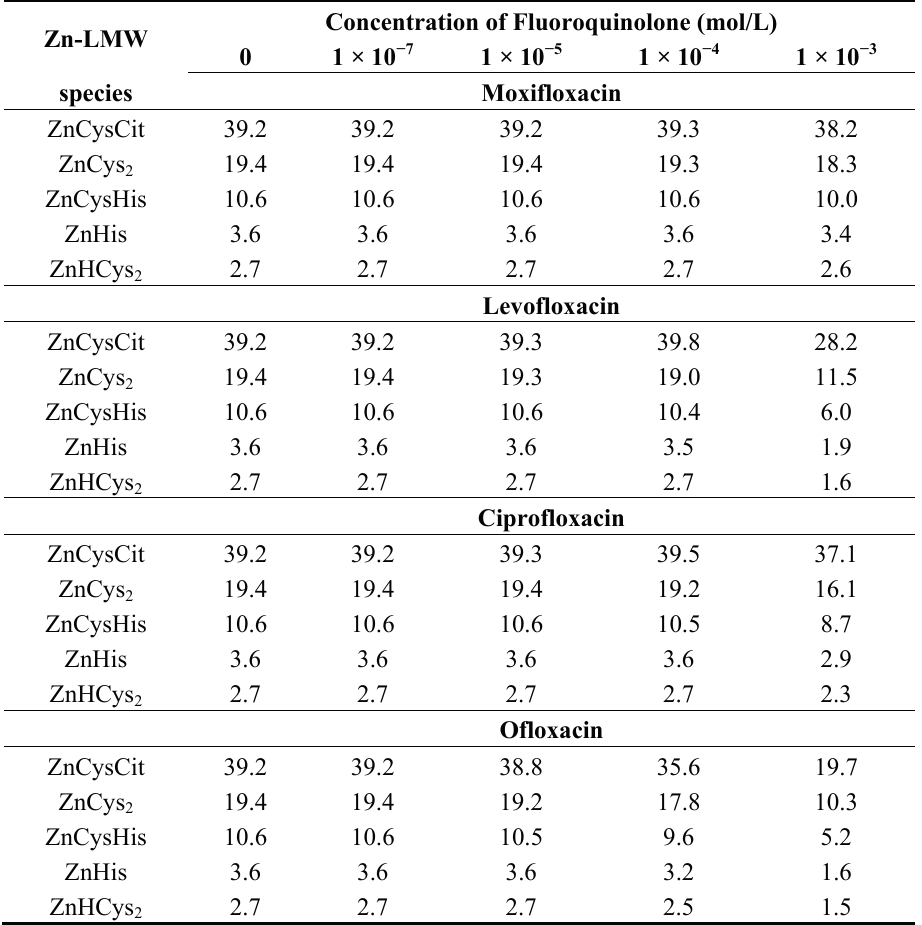
Table 11. Calculated bio-distribution of dominant Zn(II) species (%) in human blood plasma in the precense of